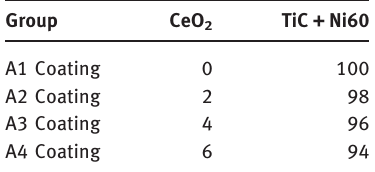
Table 2: Chemical composition of clad- ding layer powders (wt%).